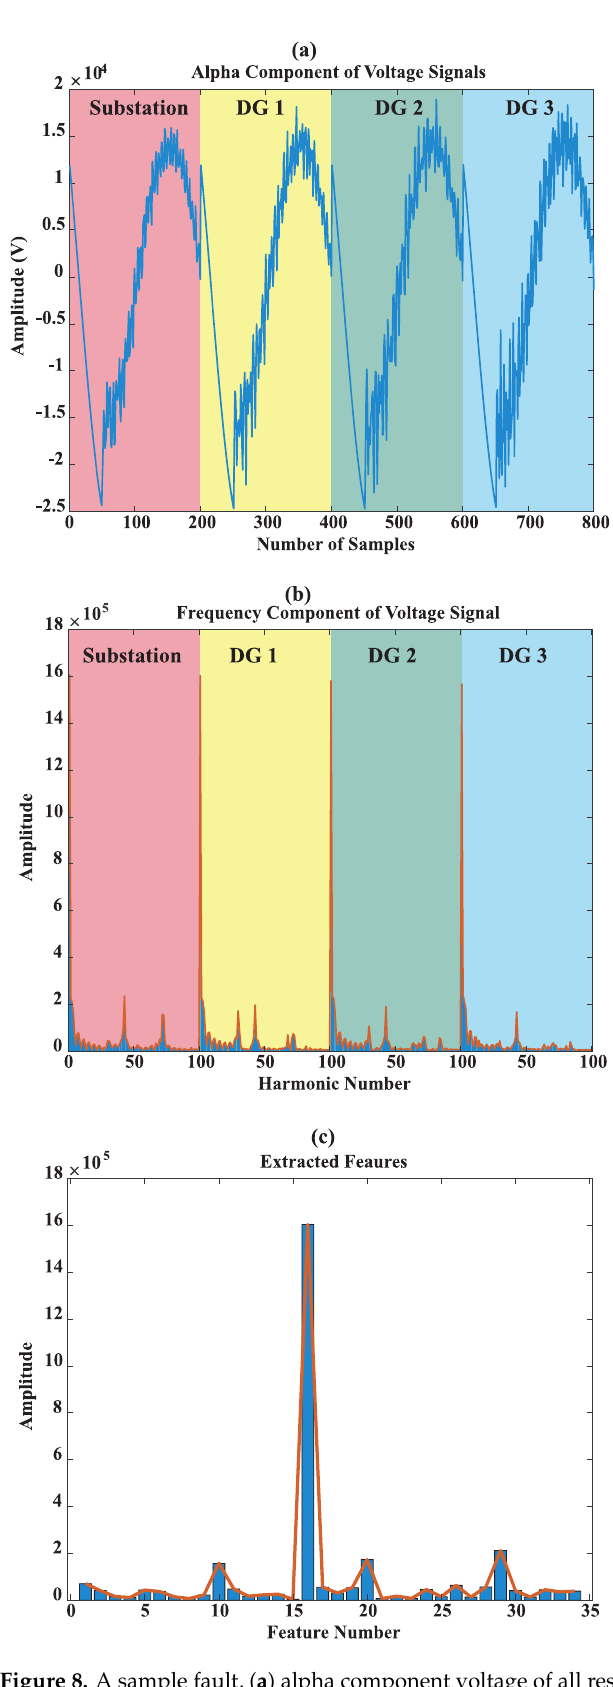
Figure 8. A sample fault, ( a ) alpha component voltage of all resources and the sub-station, ( b ) the frequency spectrum of voltage signals, ( c ) extracted the more informative features from the rest features.